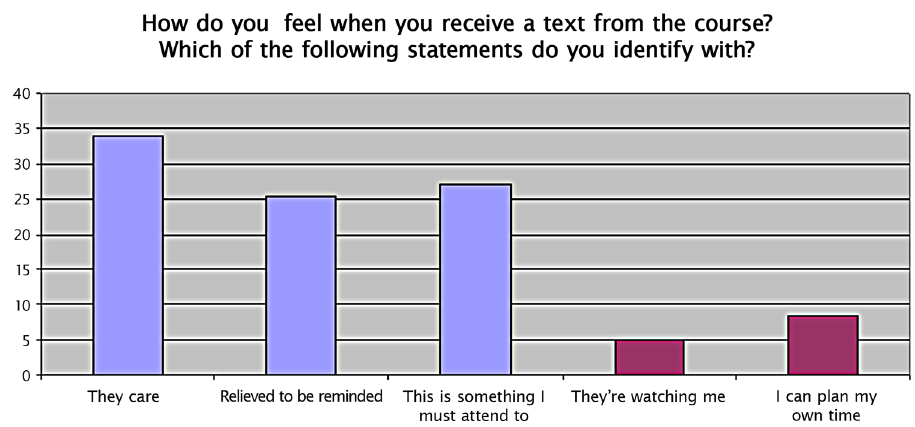
Figure 8. Percentage of students identifying with particular feelings when receiving study- related